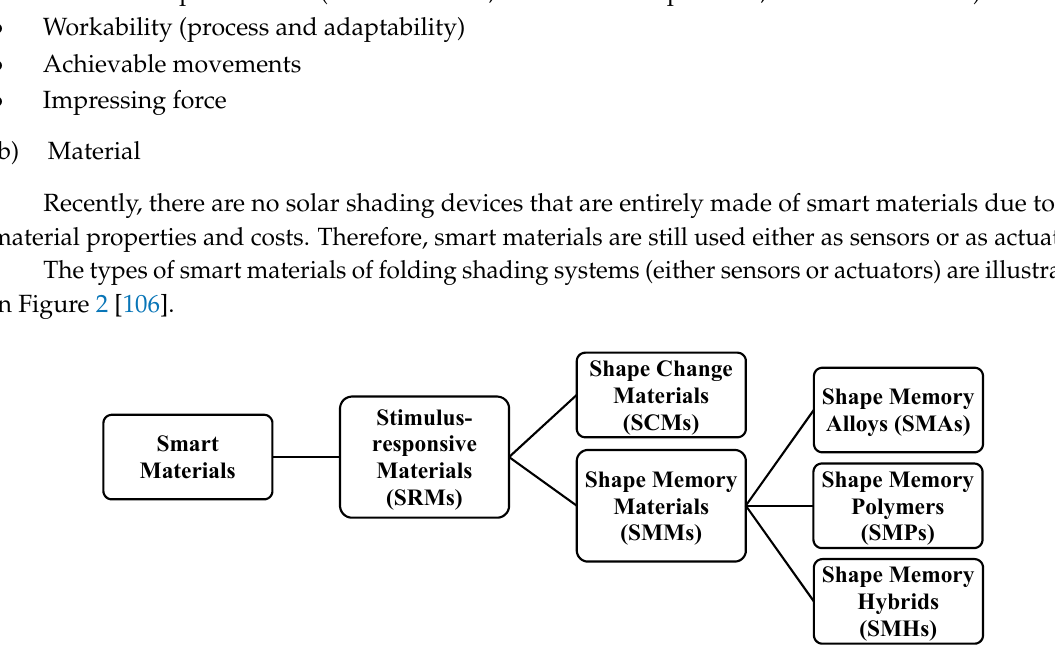
Figure 2. Smart materials types for folding shading systems.